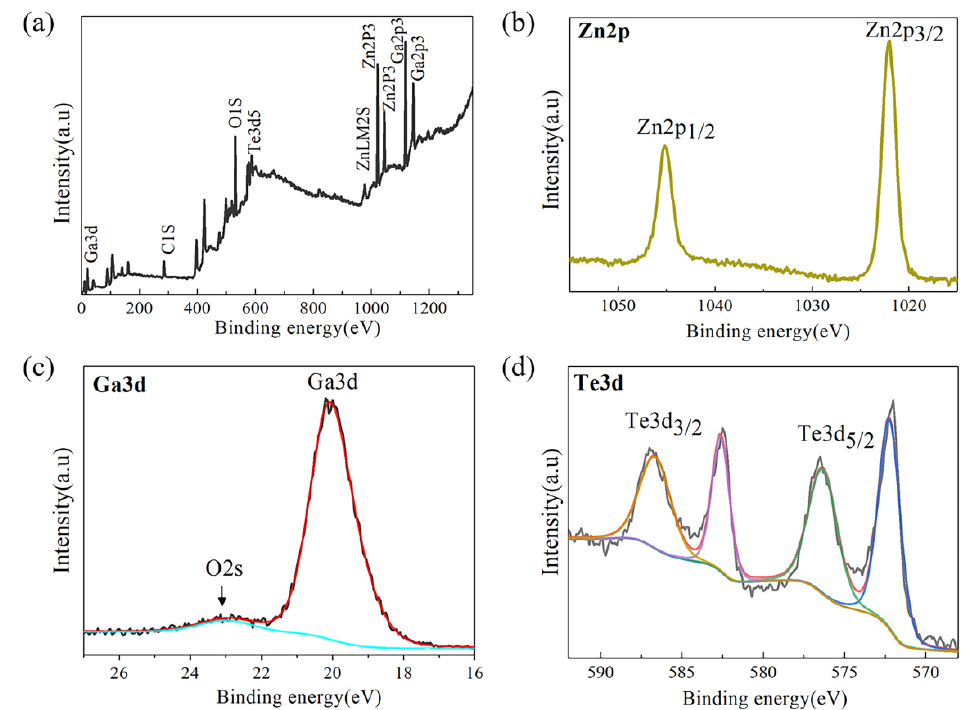
Figure 2. High resolution XPS spectra of the GaTe nanosheet flower. ( a ) XPS spectrum. Four elements are present in the spectrum: Ga and Te, from the second-step CVD products, and Zn and O, from the ZnO nanocrystals. The core levels of ( b ) Zn (2p 1/2 and 2p 3/2 ), ( c ) Ga (3d), and ( d ) Te (3d 3/2 and 3d 5/2 ).